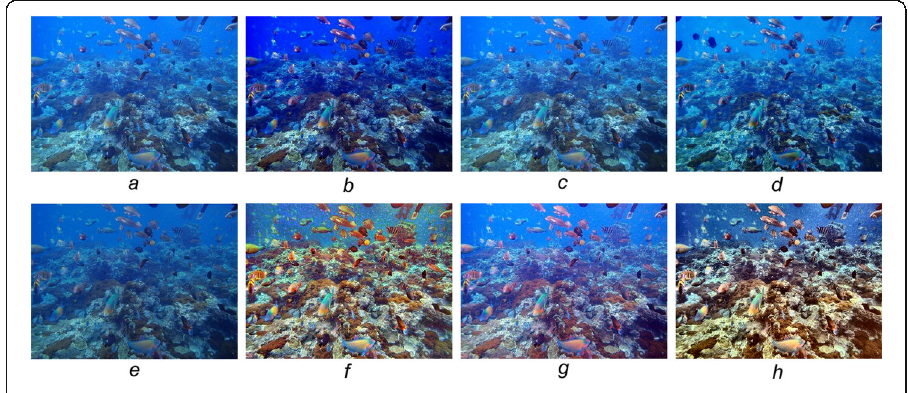
Fig. 6 Restoration results of the bluish fish image. a Input image. b With UDCP. c With ICM. d With FVR. e With DCP. f With ERD. g With IBLA. h With the proposed